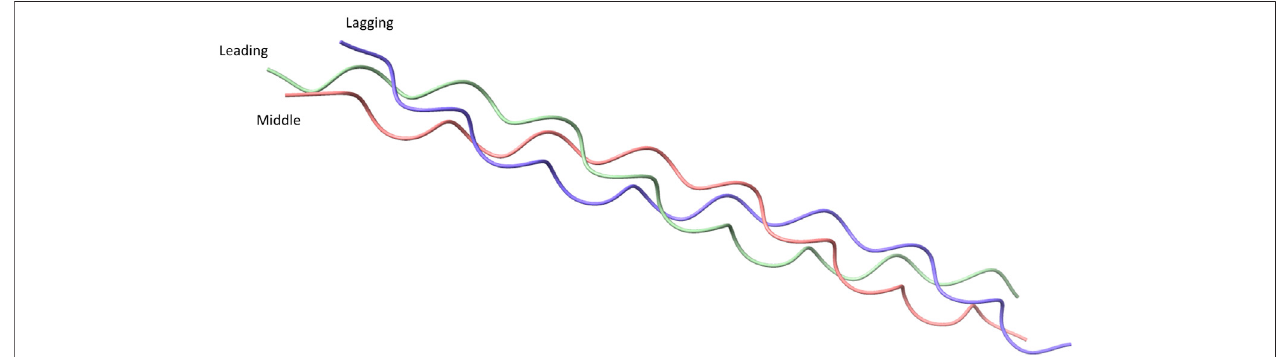
FIGURE1| Crystalstructureofacollagenpeptidewiththesequence(PPG) 10 ,accessedfrom PDBID:1K6F .Thecrystalstructureshowsthestructureofthetriple helical collagen. Three individual peptides are shown with green representing the leading strand of collagen, pink representing the middle strand, and blue representing the lagging